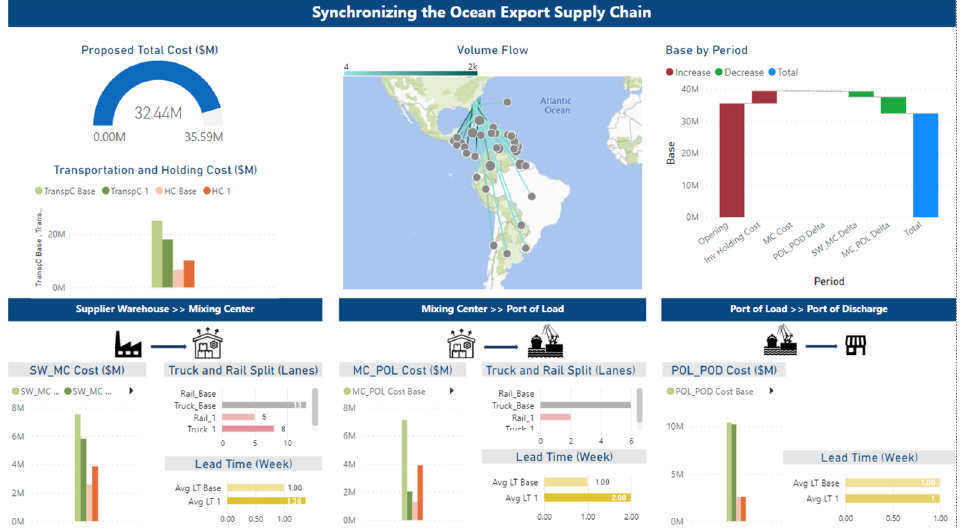
Figure 4. Summary of Base Scenario Compared to Optimization Scenarios. The legend corresponds to the notation introduced in Section 4.3.1.